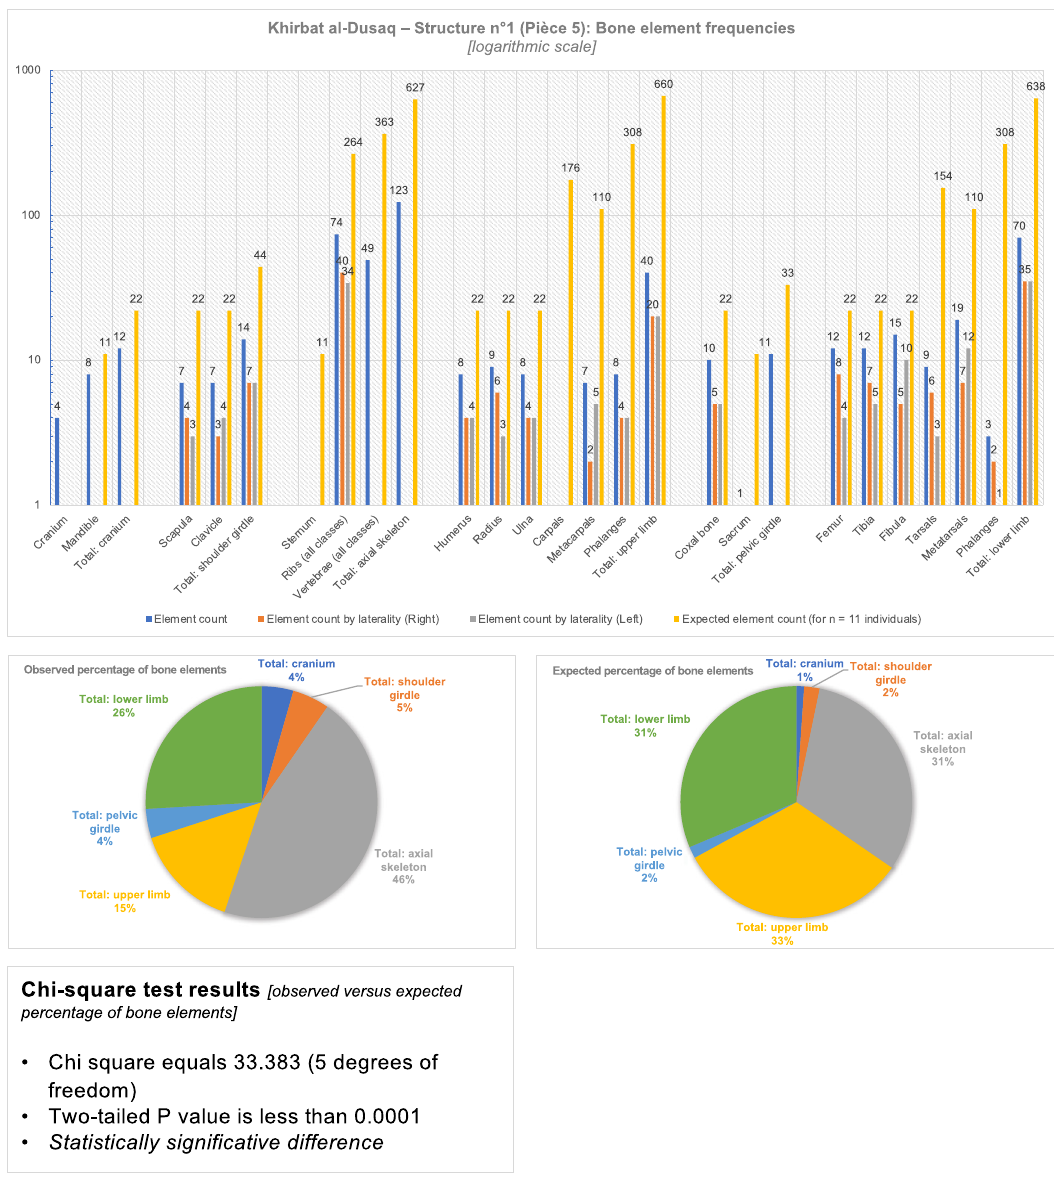
Figure 14: Structure no 1 ( Pièce 5 ) : bone element frequencies ( top ) and percentages ( bottom ) . Figures by Hofstetter ( 2022 )